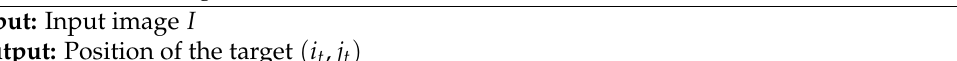
Figure 4. Flowchart of the proposed algorithm. Algorithm 1 Small target detection based on